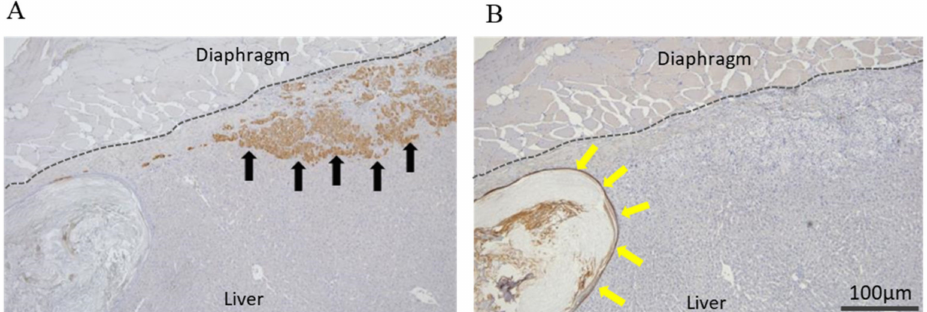
Figure 5. Histological analyses of transplanted islets and keratinocyte sheet on liver surface in the cell sheet group. ( A ) Insulin and ( B ) Cytokeratin AE1/AE3 immunohistochemical staining. The transplanted islets penetrated into the liver parenchyma (black arrows). The keratinocyte sheets that covered liver surface formed an atheroma-like mass in the liver (yellow arrows). The dotted lines indicate the boundary between the liver and the diaphragm.